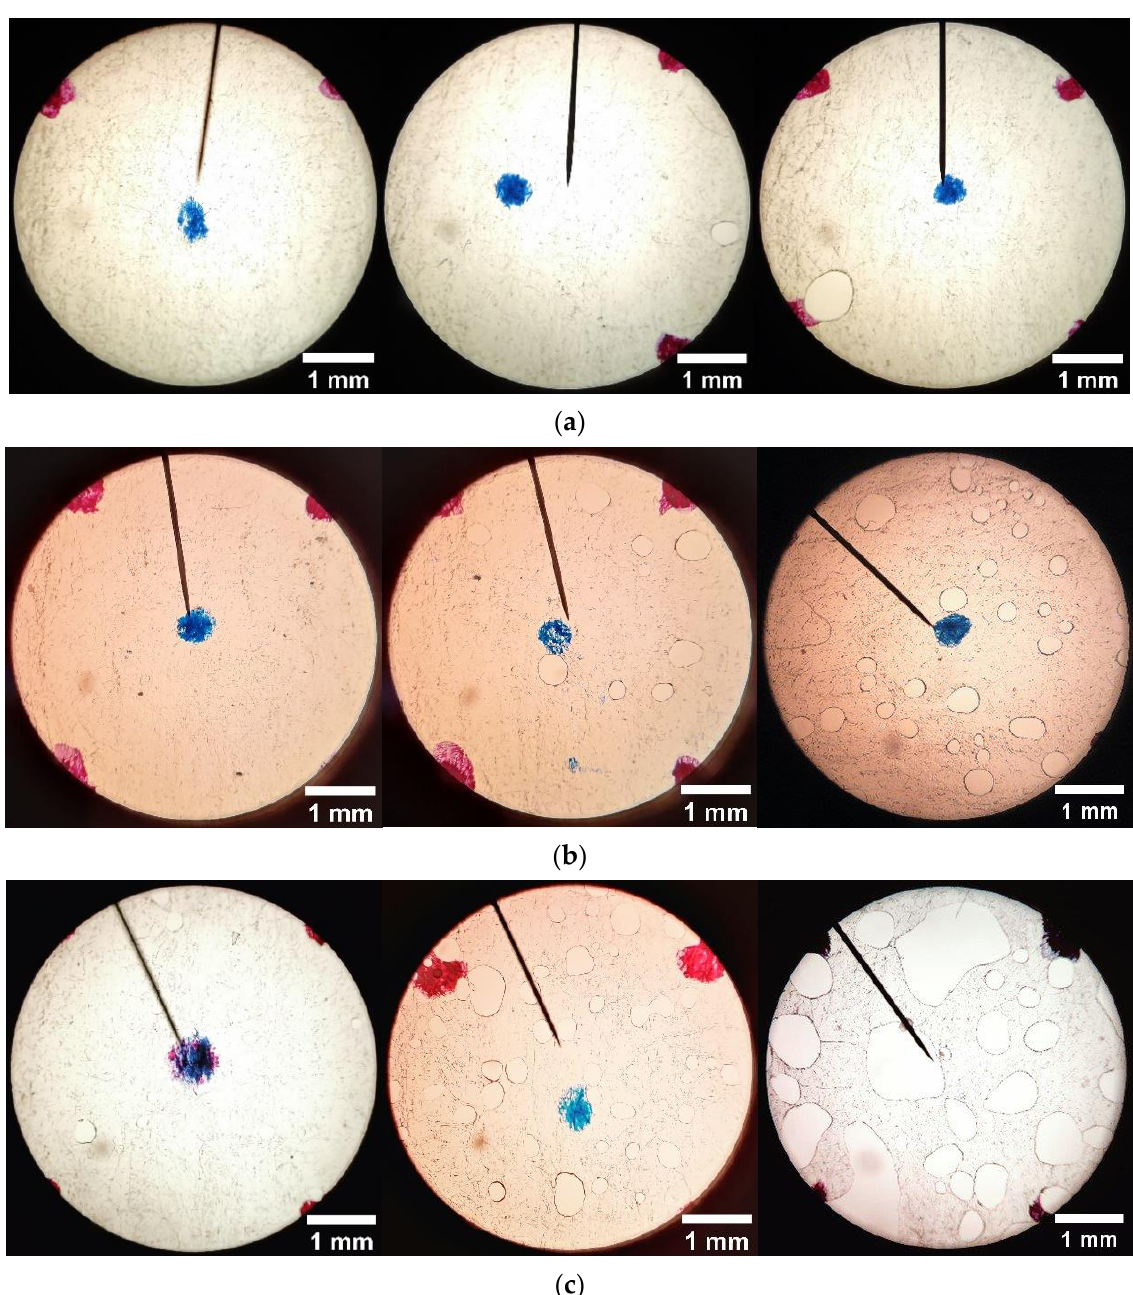
Figure 20. Typical microscopic images (40×) for ( a ) 0 kGy; ( b ) 7.0 kGy; ( c ) 11.2 kGy. Hot Press con- ditions: 6228 N, 232 °C, 5 min.